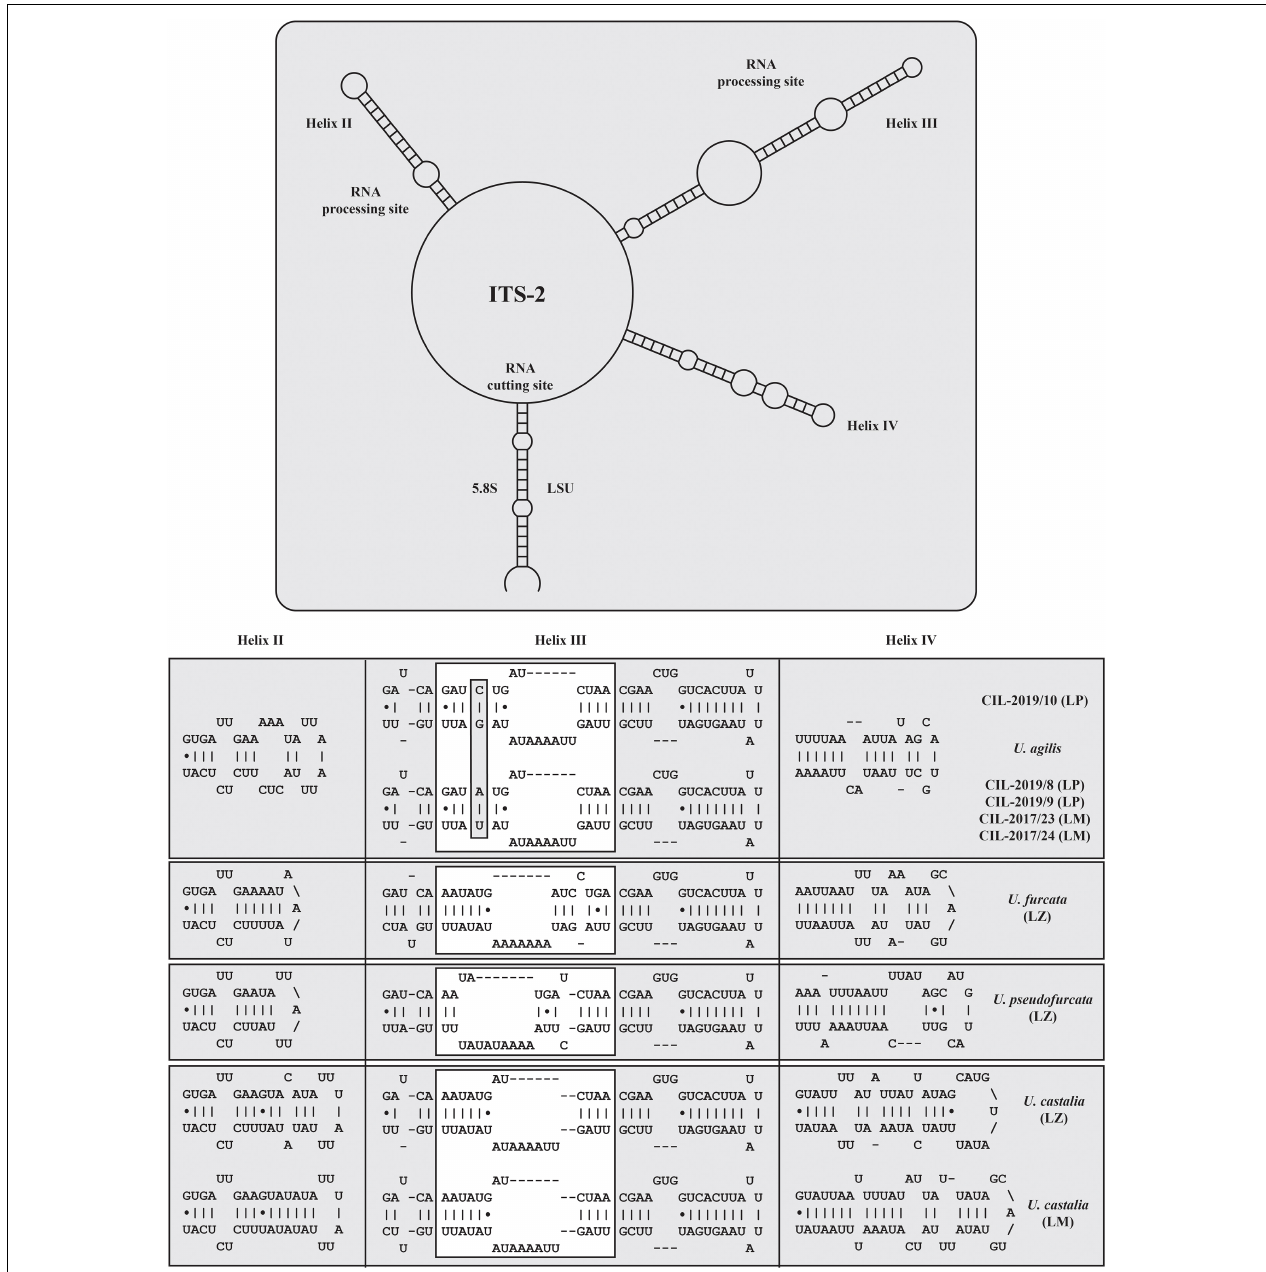
FIGURE 8 | Internal transcribed spacer-2 secondary structures of the investigated Urotricha strains. The variable regions are marked by white boxes. The compensatory base changes are highlighted. The structures were calculated with mfold. The line graphic was drawn with PseudoViewer. LP, Lake Piburg population; LM, Lake Mondsee population; LZ, Lake Zurich